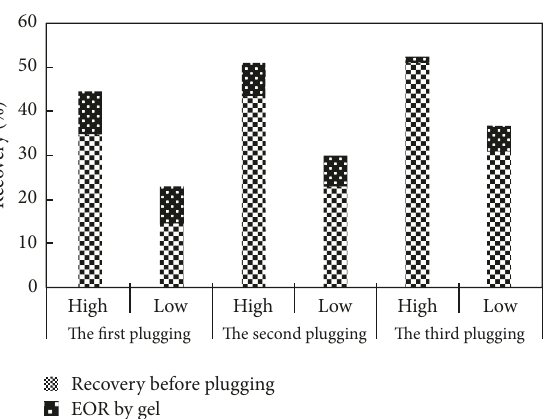
Figure 8: The sketch map of EOR by the ABP high strength